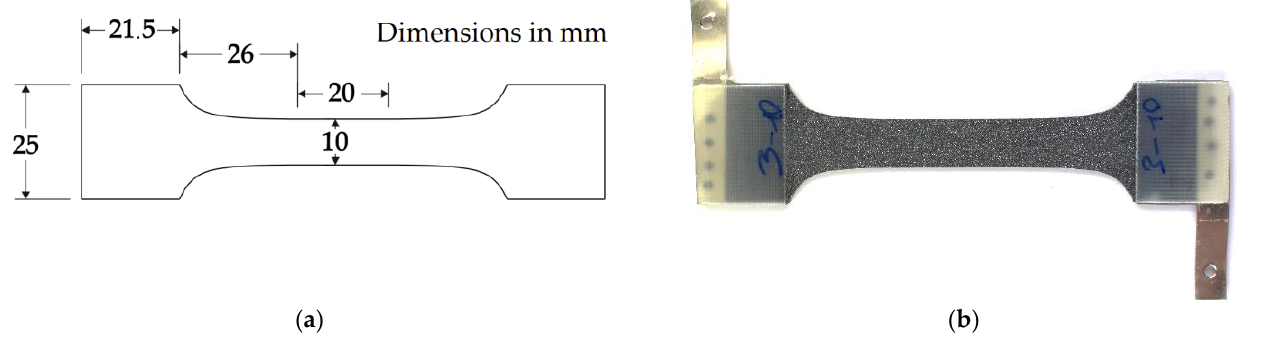
Figure 2. ( a ) Specimen geometry, ( b ) prepared specimen with adhesively bonded tabs, electrically conductive connection plates and speckle pattern for digital image correlation measurement.